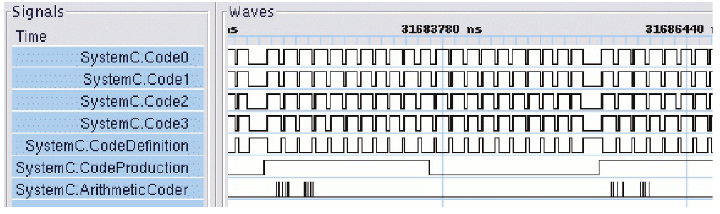
Figure 6: Extract of the task activity diagram generated during simulation of the EZT coder in configuration par-b.